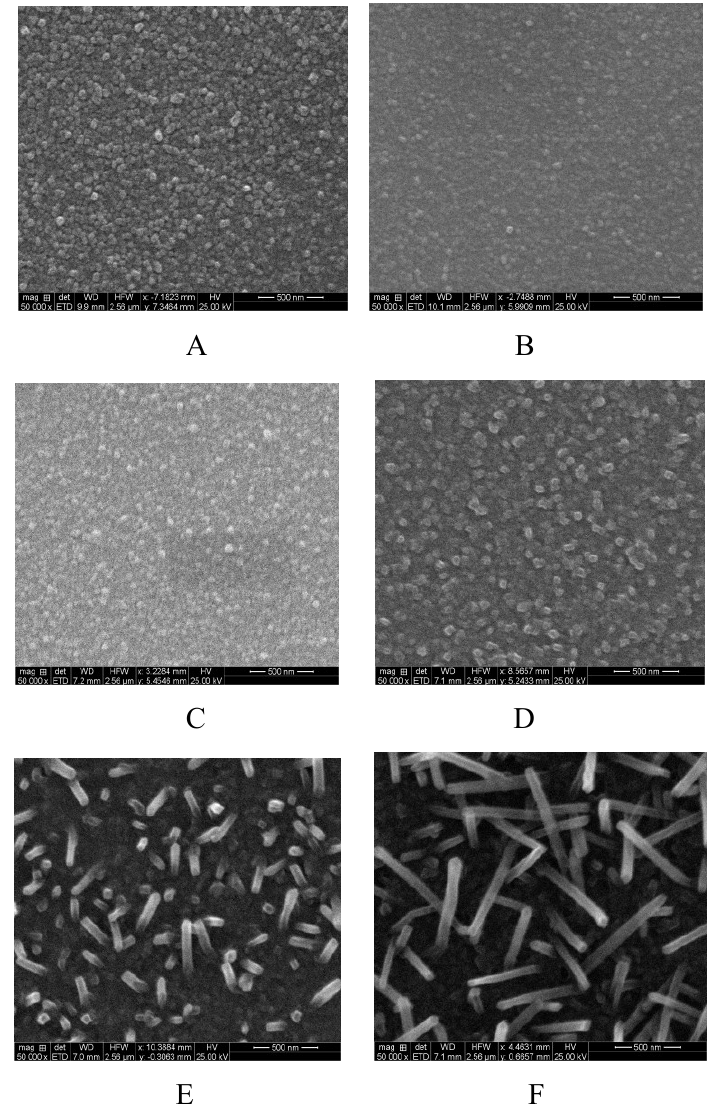
Figure 4: The surface morphologies A: as deposited, B: annealed at 323K, C: annealed at 373K,D: annealed at 423K,E: annealed at 473K, F: annealed at 523K, of